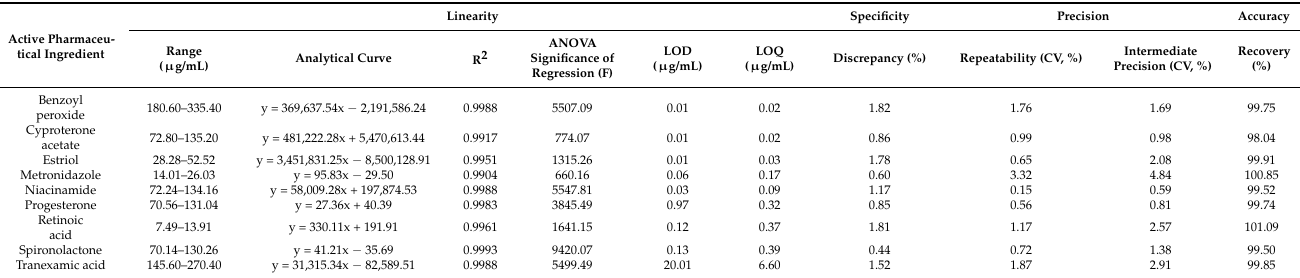
Table 3. Summary of the validation results of the HPLC